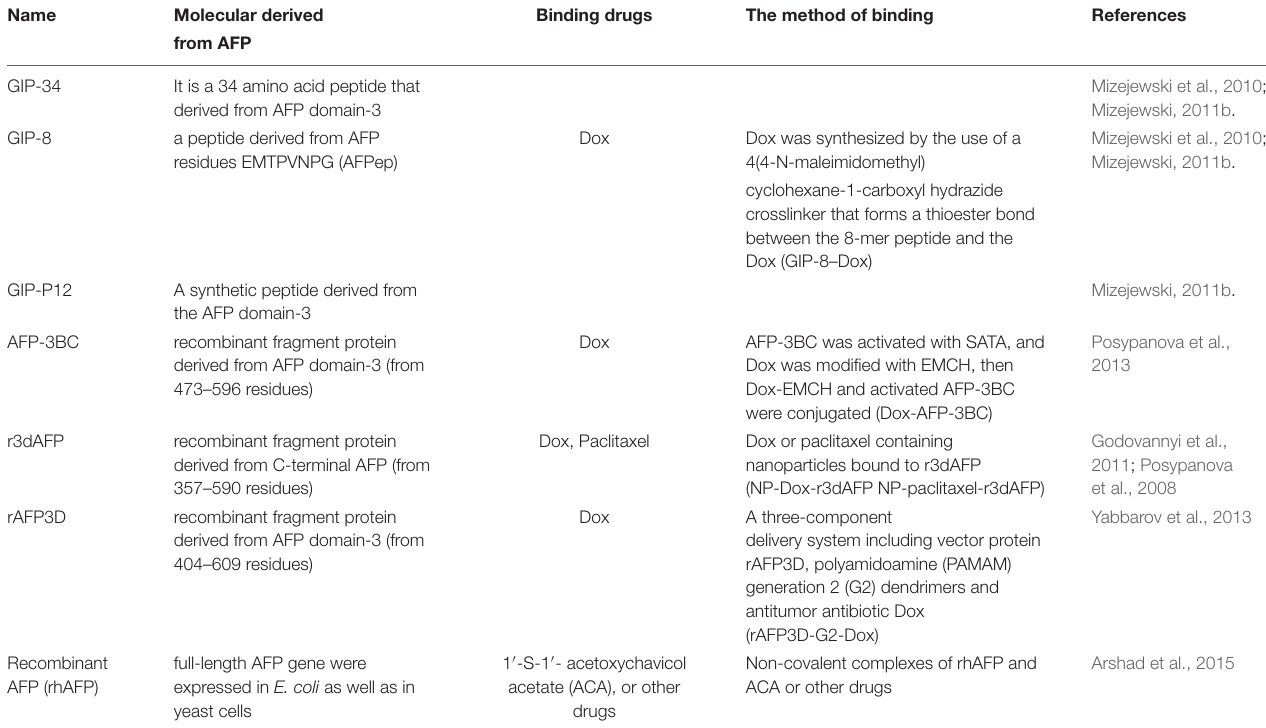
TABLE 1 | Reports of AFP-inhibiting fragments (AIFs) for the treatment of